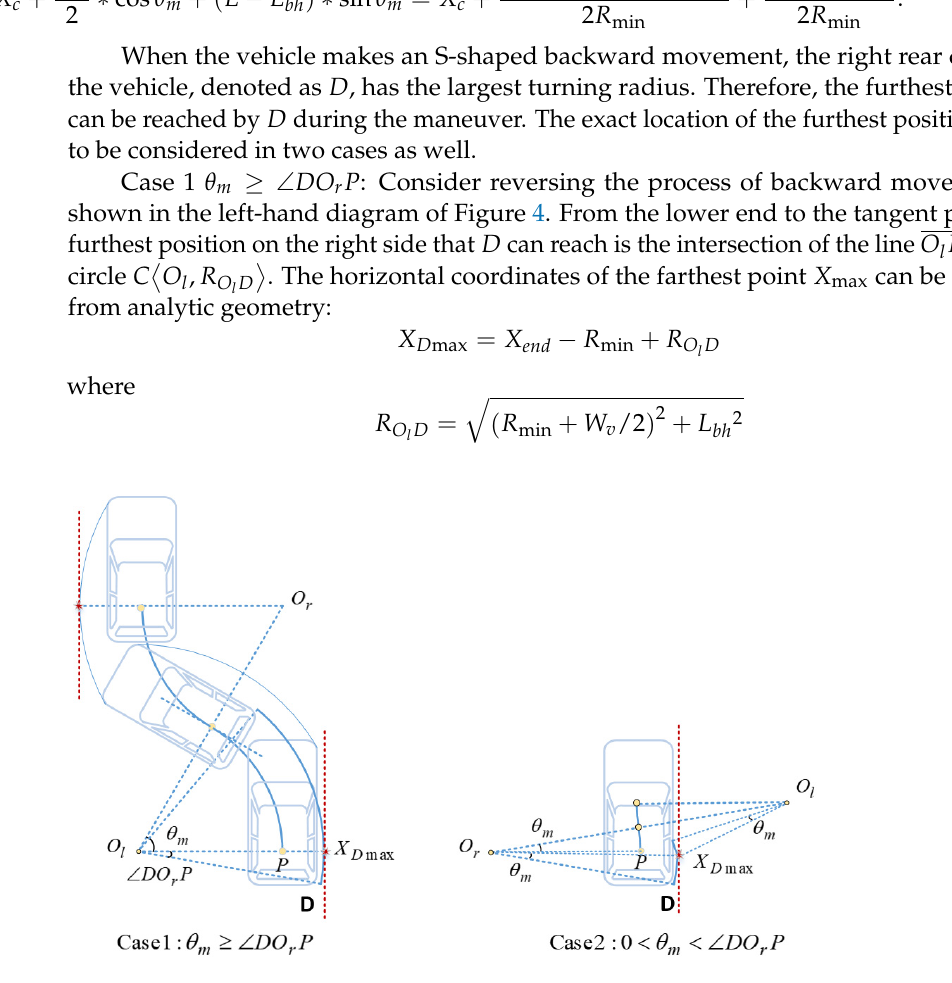
Figure 4. Two cases of S-shaped backward